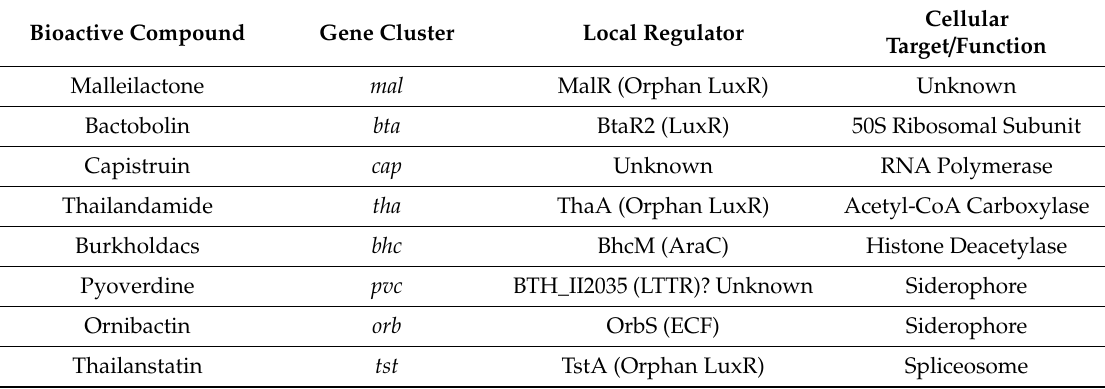
Figure 1. Chemical structures of selected secondary metabolites. Two-dimensional structures were obtained from PubChem (Malleilactone under the name Burkholderic Acid), except for Burkholdac B, which was obtained from ChEMBL (under the name Thailandepsin A) and Capistruin, for which the three-dimensional structure represents its conformation in complex with RNA polymerase (PDB ID 6N61). The complete amino acid sequence of Capistruin is GTPGFQTPD ARVISRFGFN, where bold letters denote residues linked by a backbone-sidechain lactam linkage to form the cyclic structure through which the C-terminal residues are threaded. Images were rendered with PyMol. C, yellow; O, red; N, blue; H, grey; S, orange; Cl, green. Table 1. Local regulators of biosynthetic gene clusters.